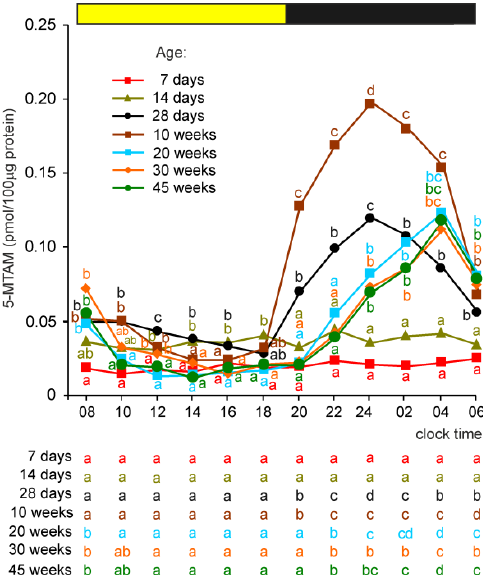
Figure 7. Concentration (means) of 5-methoxytryptamine, 5-MTAM, in the pineal organs of turkeys at the ages of 2, 7, 14, 28 days and 10, 20, 30, 45 weeks. The horizontal bar represents the periods of light and dark phases of the daily cycle. The letters on the charts show differences between age groups at each time-point in Duncan’s test. The letters below the charts show differences between time-points within a group in Duncan’s test. The same letters indicate means which are not significantly different. The concentration of 5-MTAM was undetectable in the pineal organs of turkeys aged 2 days.